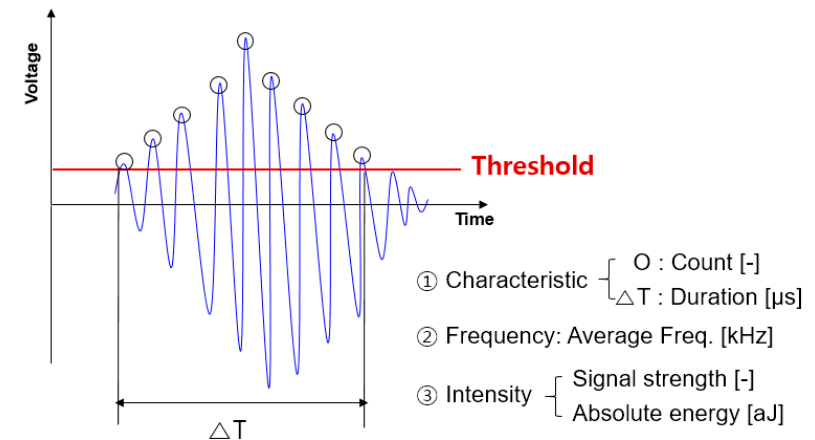
Figure 4. Characteristics of AE.